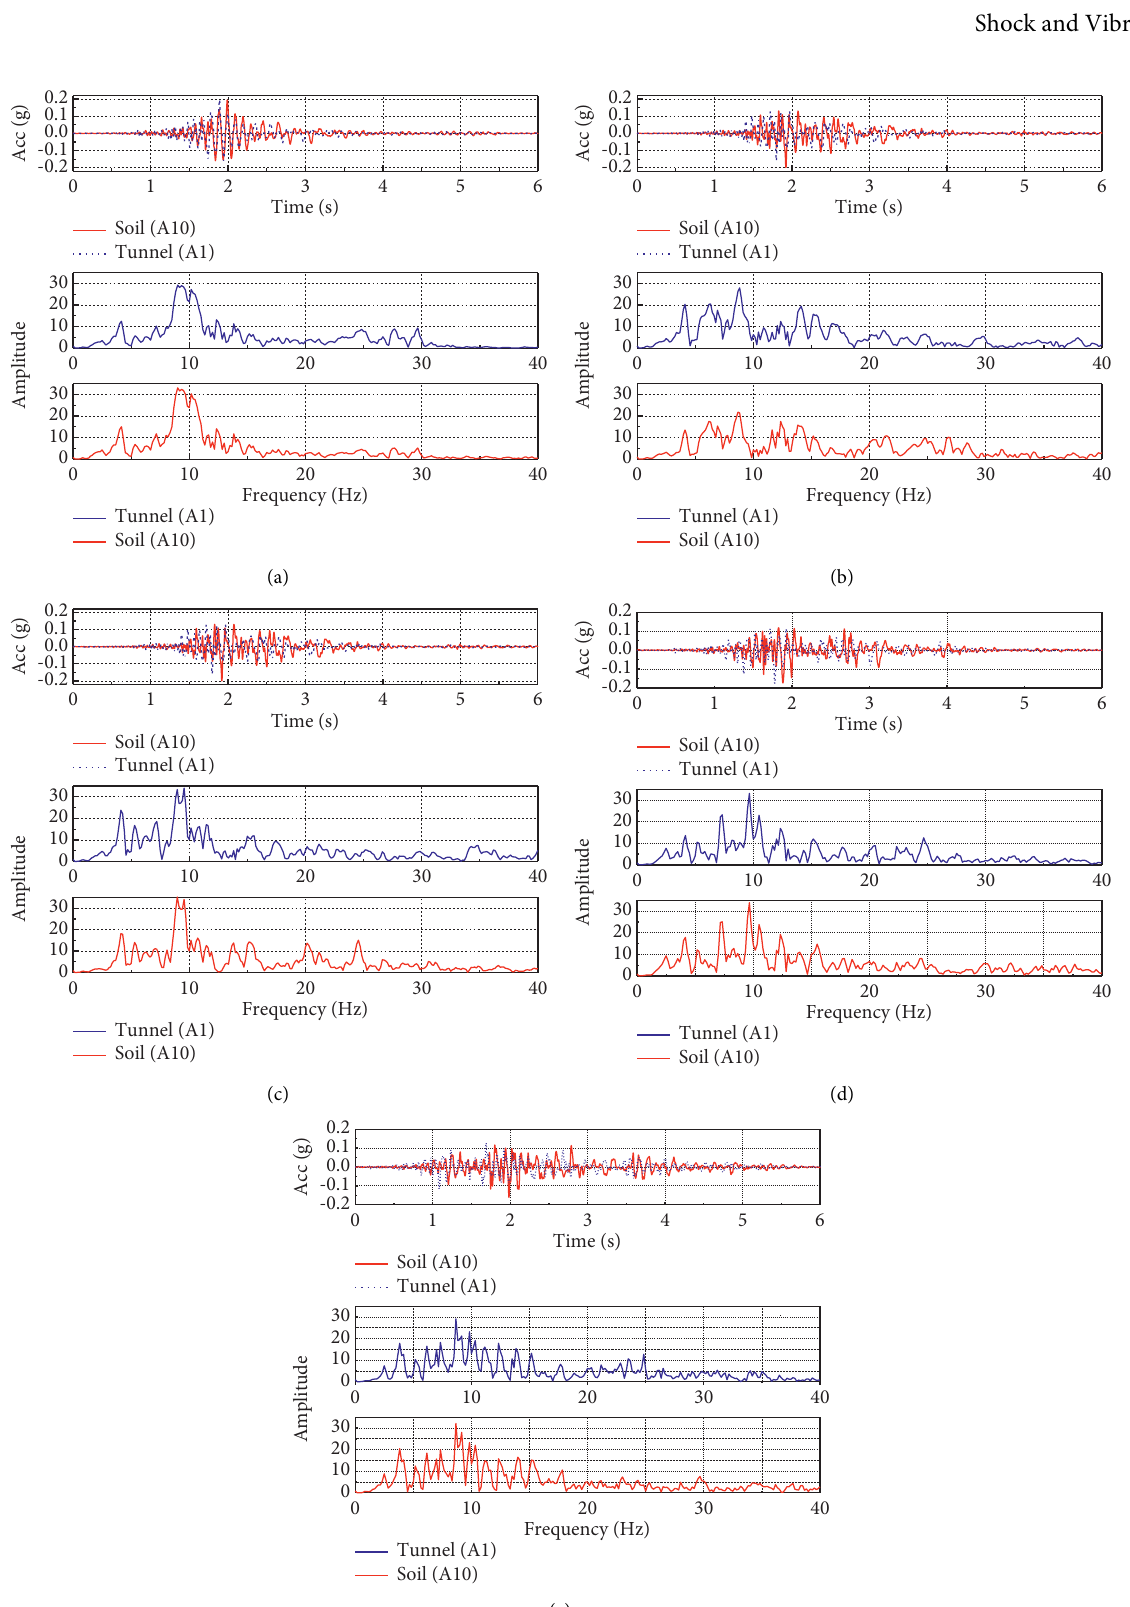
Figure 12: Time histories and its corresponding autospectrum for A1 and